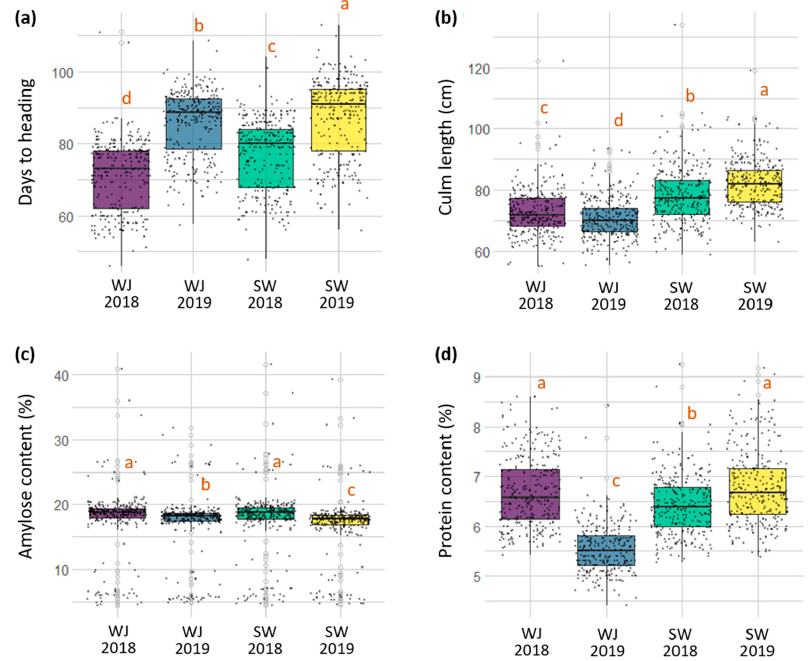
Figure 1. Variation in days to heading ( a ), culm length ( b ), amylose content ( c ), and protein content ( d ) of 293 Korean rice cultivars evaluated at two different locations (WJ—Wanju; SW—Suwon) for two years (2018 and 2019). Different lowercase letters above the box plots indicate a significant difference according to Tukey’s multiple comparisons at p < 0.05. Culm length (CL): The average CL of the 293 cultivars was 72.8 cm (55–122 cm) in Wanju and 78.2 cm (59–134 cm) in Suwon in 2018, and 70.8 cm (55–93 cm) in Wanju and 82.1 cm (63–119 cm) in Suwon in 2019 (Figure 1b). While DTH were delayed by early